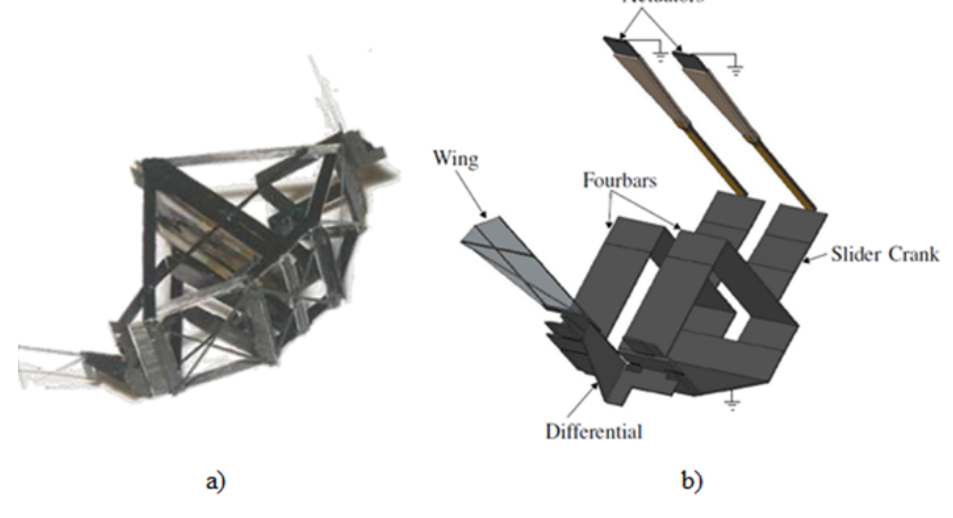
Figure 6. ( a ) Current Micromechanical Flying Insect (MFI) design (4DOF); ( b ) Flying Insect Thorax